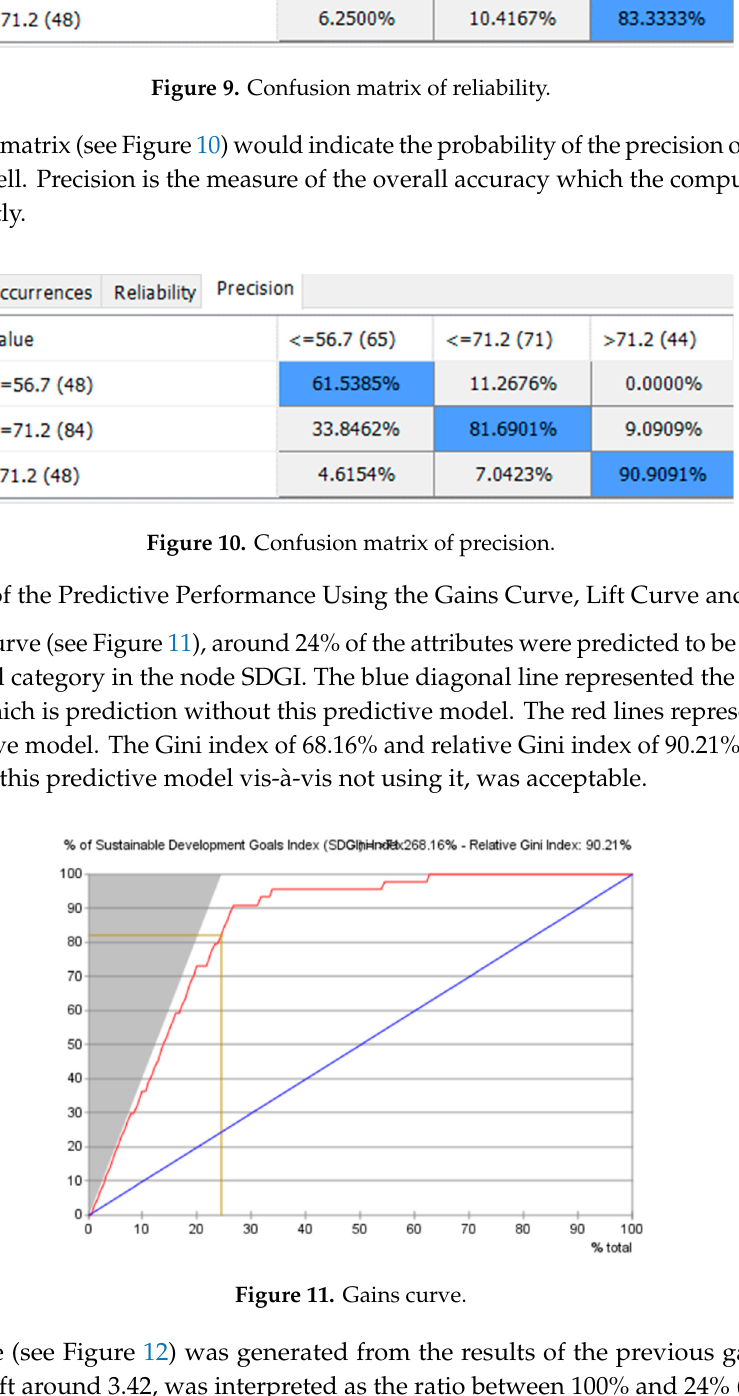
Figure 9. Confusion matrix of reliability.